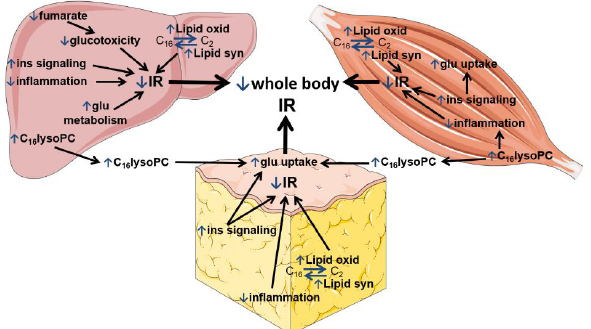
Figure 7. BEZ-modified metabolic pathways, which reduce whole-body insulin resistance (IR). The figure summarizes the beneficial effects of BEZ in the liver (left side), skeletal muscle (right side) and white adipose tissue (in the middle), which are possibly involved in insulin sensitivity, glucose and lipid metabolism reducing whole- body insulin resistance (IR). Blue “ ↑ ” or “ ↓ ” arrows show BEZ-activated or BEZ-inhibited pathways. Abbreviations: lipid oxid: lipid oxidation, lipid syn: lipid synthesis, ins: insulin, glu: glucose, lysoPC: lysophosphatidylcholine, IR: insulin